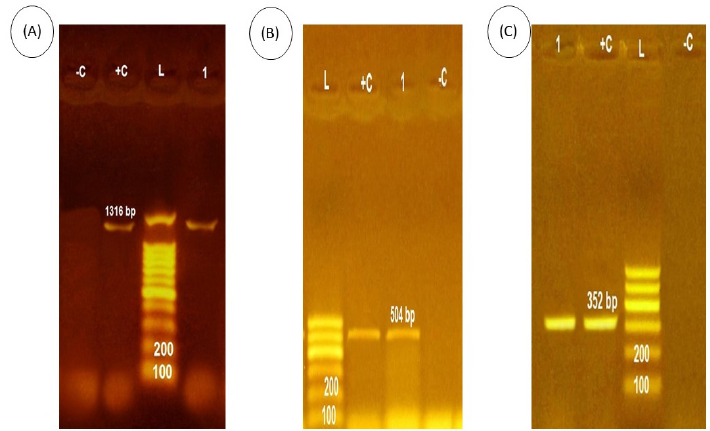
Figure 1. PCR amplicons of P. putida toxin gene. ( A ): the expression of nan1, Lane L, 100-bp ladder, Lane +c, positive control. Lane 4 ( − c), negative control. Lane 1, P. putida isolates which were positive for gene expression at 1316. ( B ): the expression of exoS, Lane L, 100-bp ladder, Lane +c, positive control. Lane ( − c), negative control. Lane 1, P. putida isolates, which were positive for gene expression at 504 bp. ( C ): the expression of toxA, Lane L, 100-bp ladder, Lane +c, positive control. Lane 4 ( − c), negative control. Lane 1, P. putida isolates, which were positive for gene expression at 352 bp.